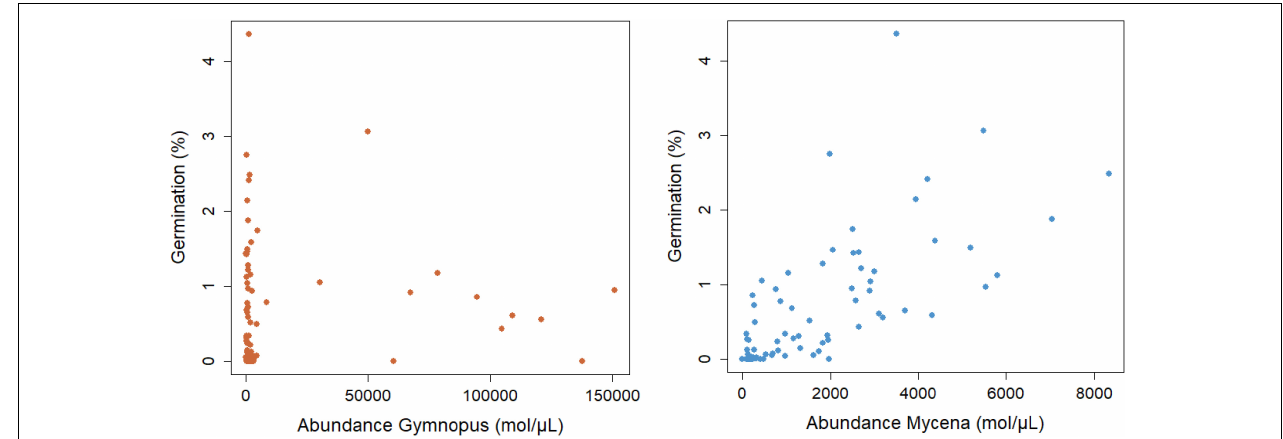
FIGURE 5 | Relationship between the abundance of Mycena (OTU3) and Gymnopus (OTU5) DNA molecules µ L − 1 DNA extract and percentage seed germination of Gastrodia confusoides . Seed germination was expressed as the percentage of seeds developing into a protocorm.